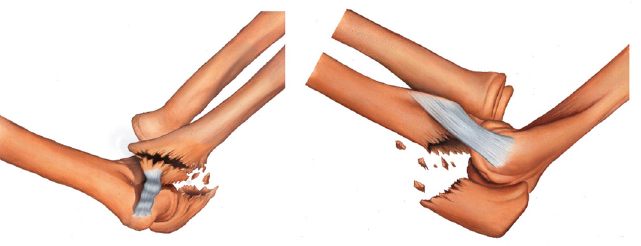
ture of the sublime tubercle (Figure 4).